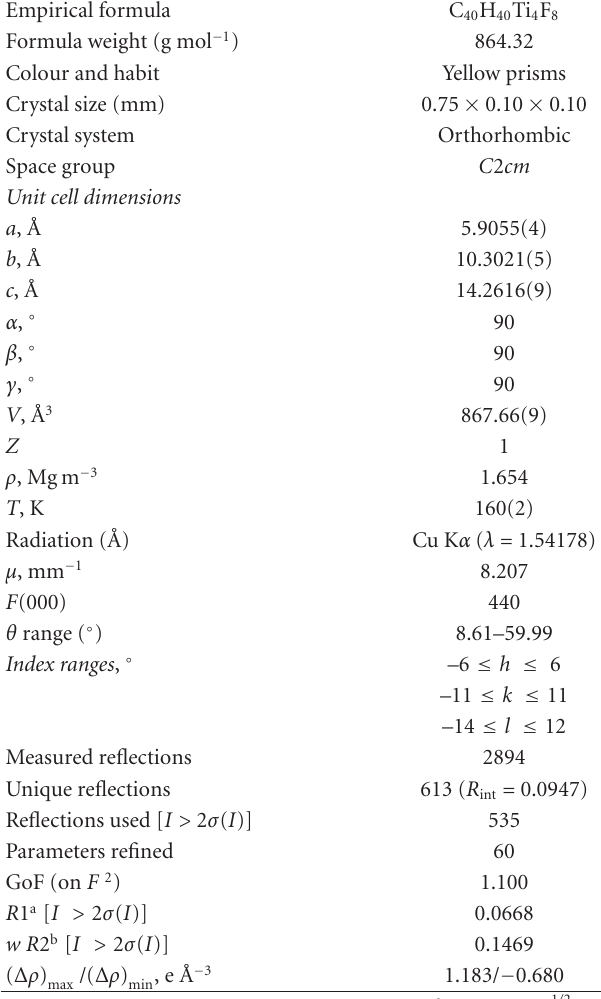
Table 1: Crystallographic data and structure refinement for complex 1